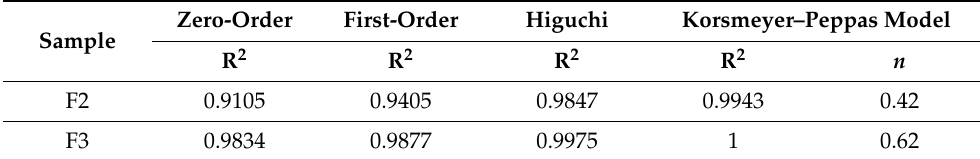
Table 6. In vitro release kinetics data of the two TE-loaded electrospun fiber mats fitted to mathematical